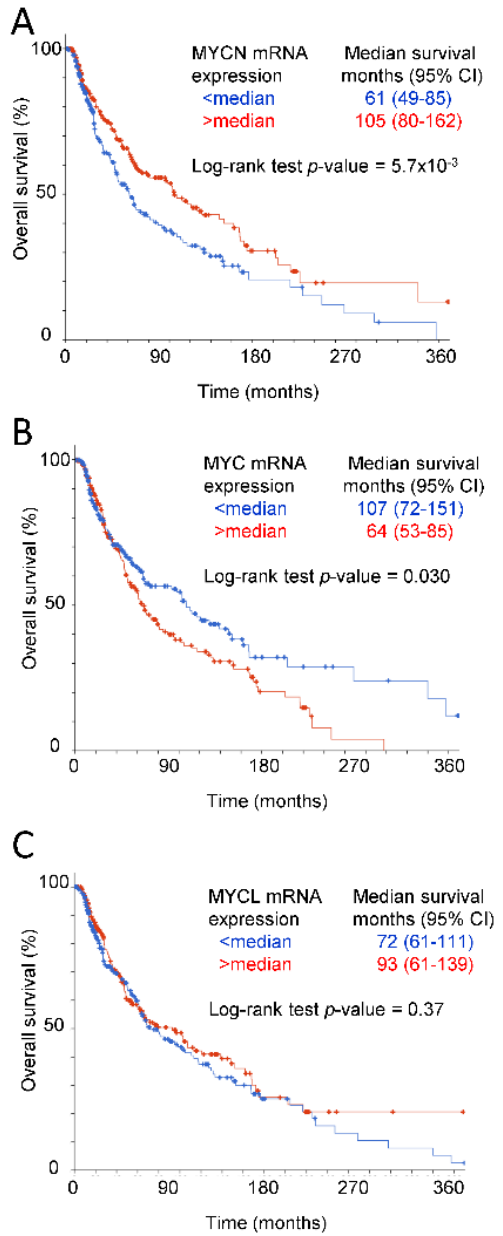
Figure 5. Association of MYC family mRNA expression with overall survival in human melanomas. Kaplan–Meier plots indicate the overall survival of 469 melanoma patients with MYCN ( A ), MYC ( B ), or MYCL ( C ) mRNA expression greater than or less than the median. The median survival of each group is presented with the respective 95% confidence intervals.